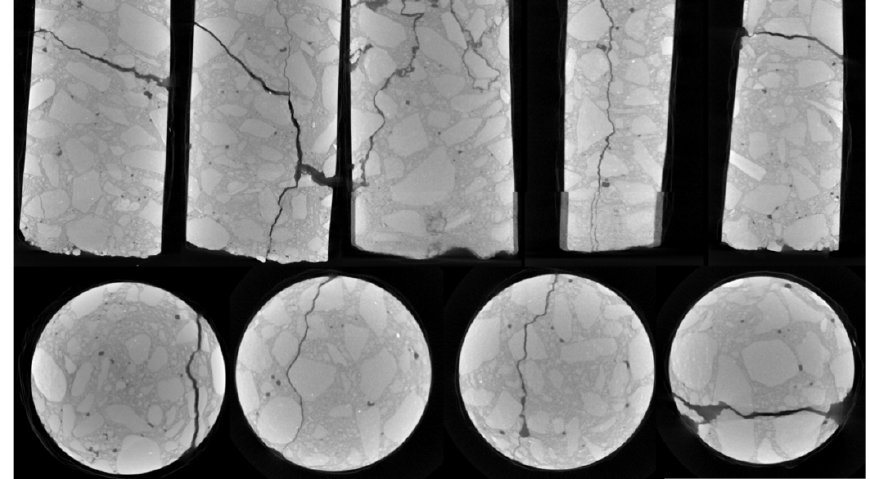
Figure 9. Type-III crack .